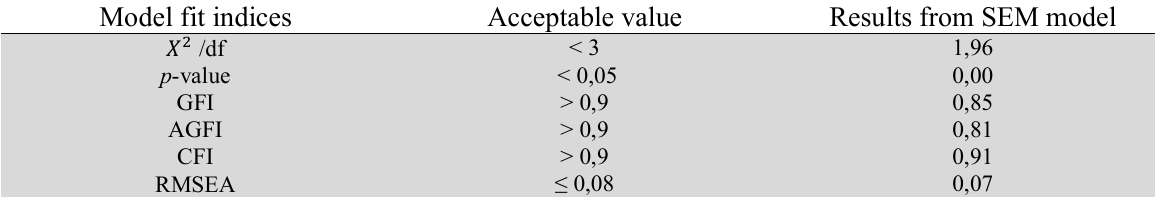
Results of the relevance of the SEM model